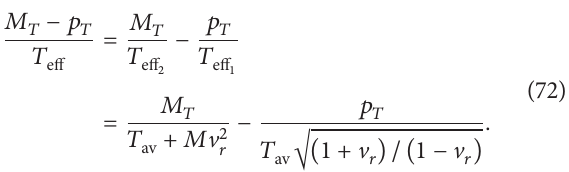
Figure 27: Variation thermal photon to dilepton ratio, 𝑅 (b) (see